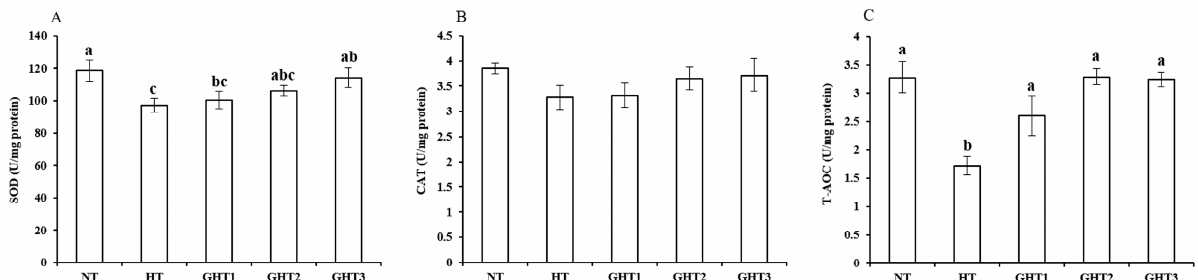
Figure 3. Effect of Gln on SOD ( A ), CAT ( B ), and T-AOC ( C ) levels on the livers of broilers exposed to high temperature conditions. Different lowercase letters above each column indicate significant ( p < 0.05) differences among the groups. NT group: Broilers were kept in the normal temperature environment and fed a basal diet. HT, GHT1, GHT2, and GHT3 groups: Broilers in these groups were kept in high temperature conditions and fed a basal diet supplemented with 0%, 0.5%, 1.0%, and 1.5% Gln.